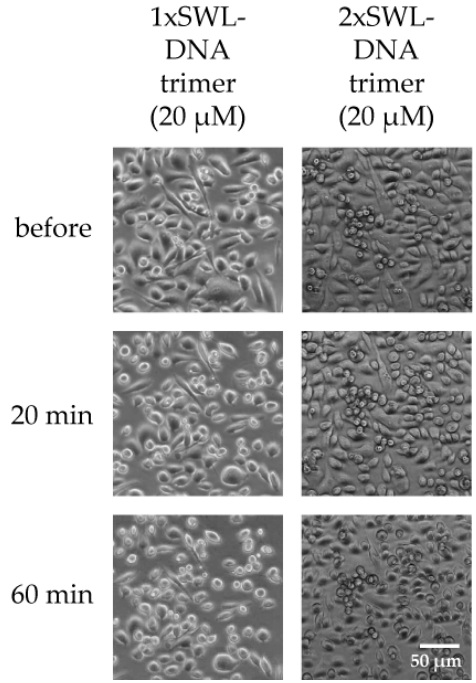
Figure A8. PC-3 cell rounding. Cells were seeded the day before and serum-starved for 4 h prior treatment. Samples were diluted in PBS and incubated on cells for indicated times. Cell morphology was observed and 20 and 60 min to account for inherent rounding effects from serum starvation.